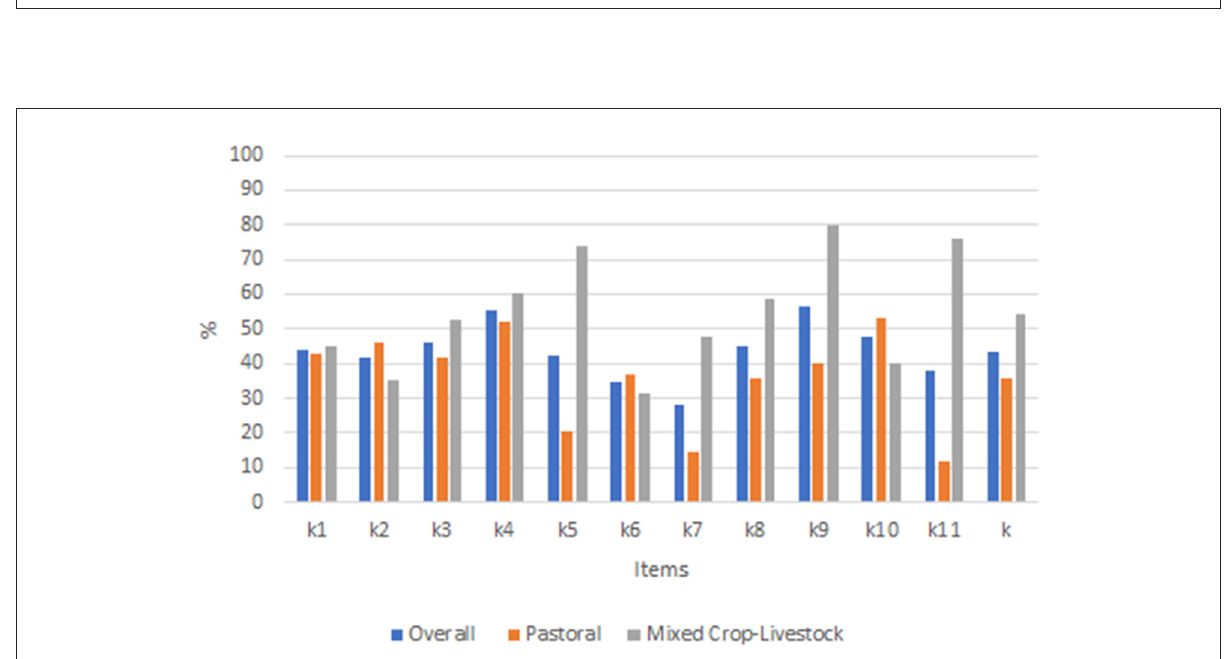
FIGURE5 Percent of correct responses for animal welfare knowledge items aggregated by production system in